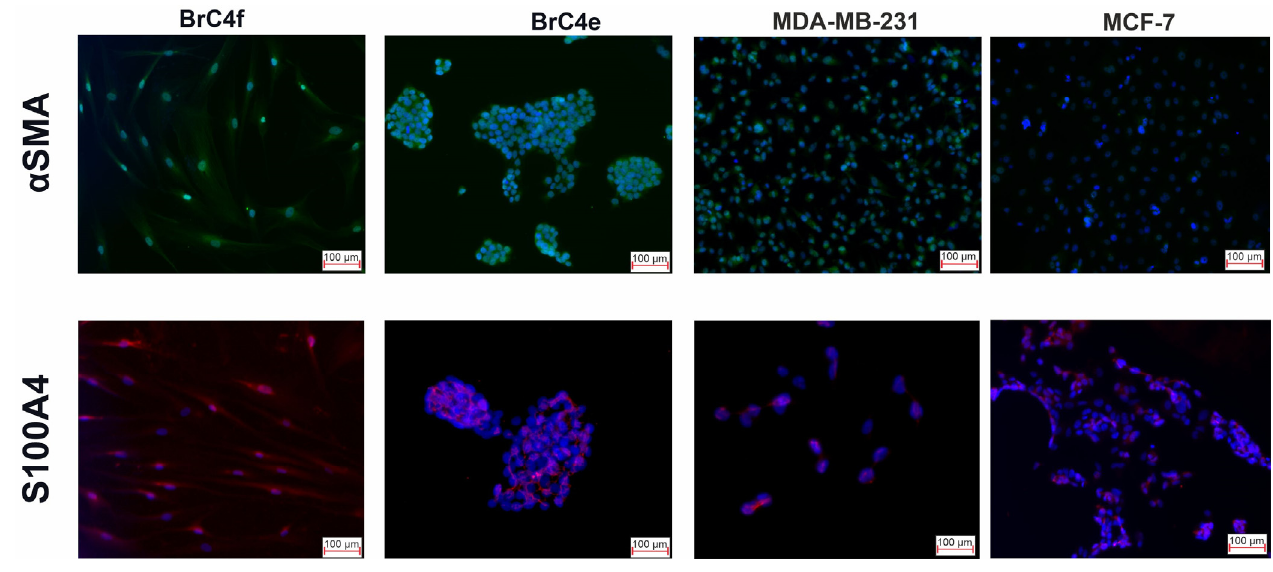
Figure 3. Immunofluorescence staining for cytoskeletal markers. FITC-conjugated anti- α SMA (green signal) and Alexa Fluor 555-conjugated anti- S100A4 (red signal) antibodies were used.